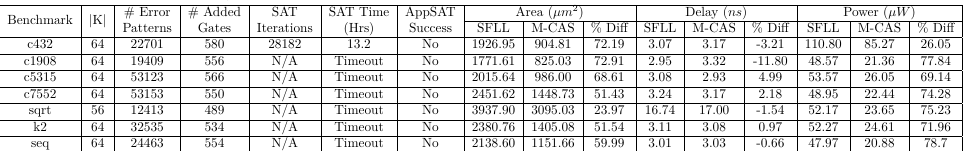
Table 1: SAT and AppSAT resistance of various M-CAS locked logic cones, along with area, power and delay comparisons to